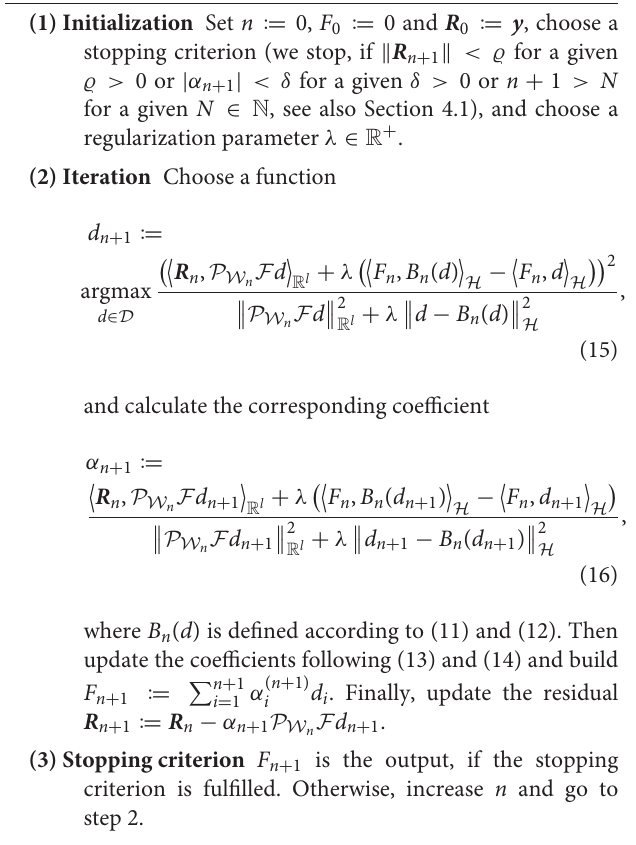
Algorithm 2.2 Let a dictionary D and an operator F : H